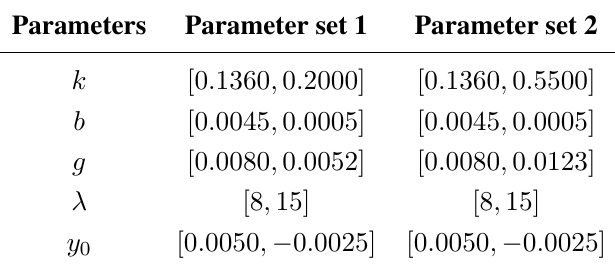
Table 1. Parameter sets used for Example 1.